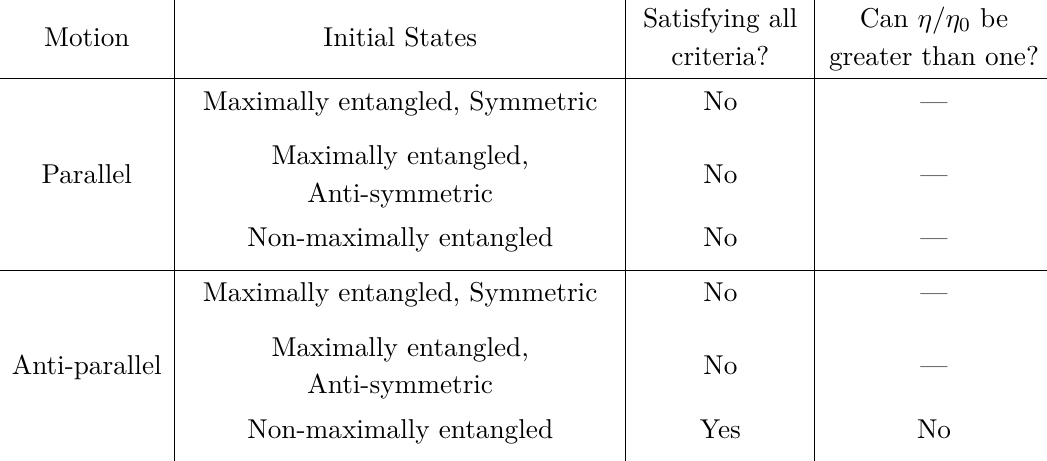
Table 2. Summery of possible scenarios of